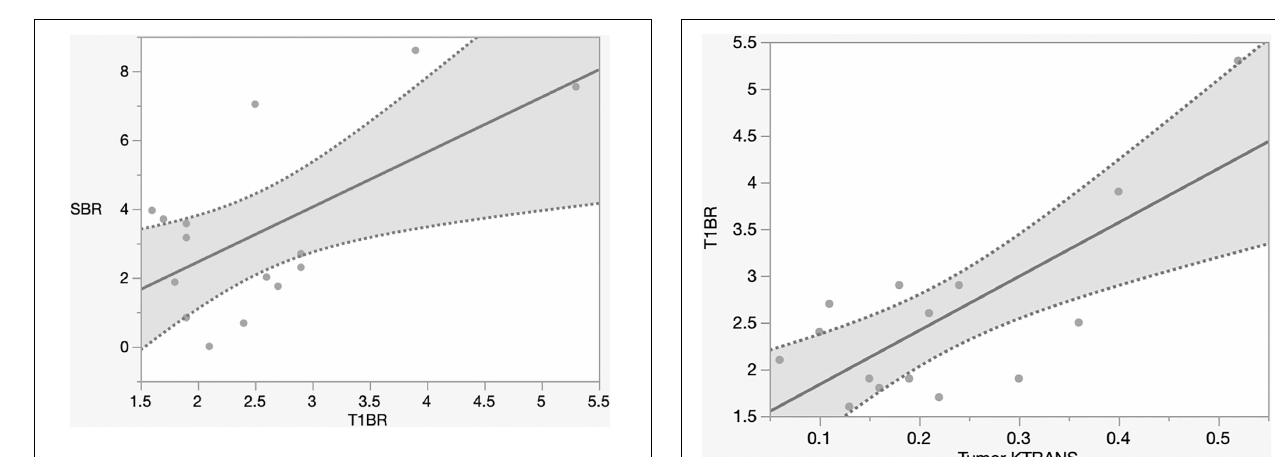
FIGURE 4 | Linear regression plot of NIR. SBR of the tumor versus magnetic resonance imaging signal intensity ratio of the tumor on T1-contrast scan. The SBR increased with the ratio of gadolinium-enhanced T1 tumor signal to the normal brain ( p = 0.016, R 2 = 0.36). NIR, near-infrared; SBR, signal–background ratio; K trans , volume transfer constant; T1BR, ratio of gadolinium-enhanced T1 tumor signal to the brain.